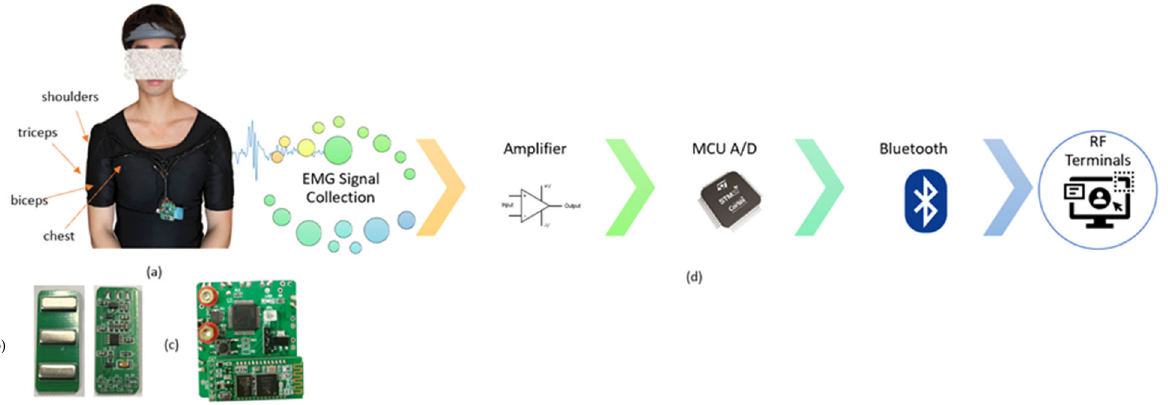
Figure 1. ( a ) Positions of EMG sensing electrode in wearable EMG fitness shirt; ( b ) EMG sensing electrode; ( c ) PCB; ( d ) Signal transmission pipeline.